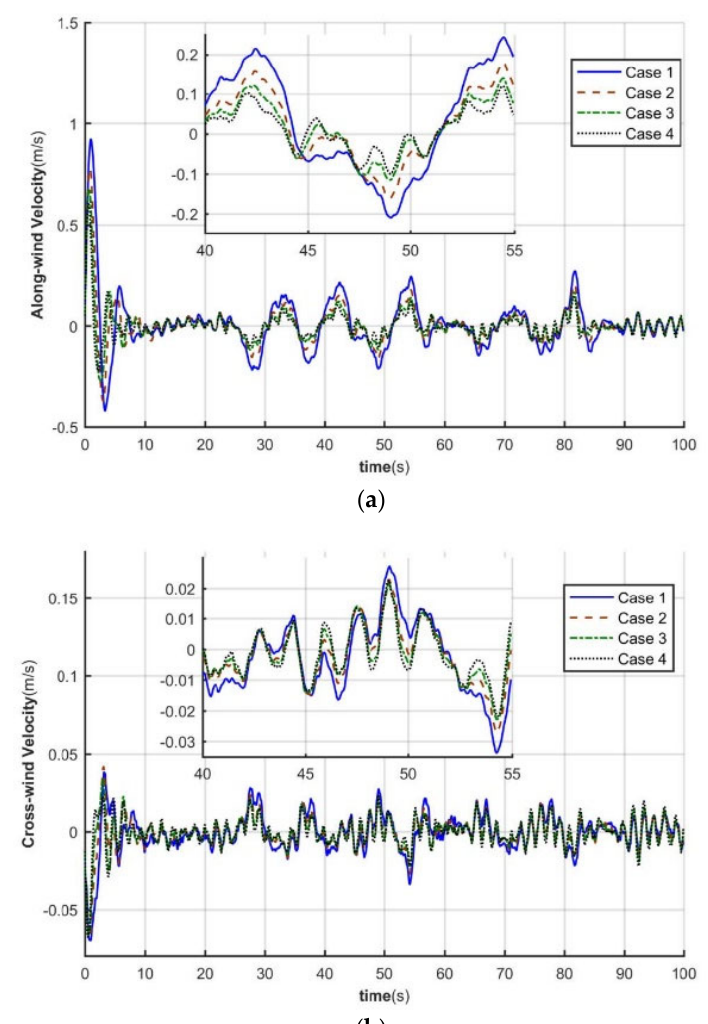
Figure 12. Time course of tower top speed ( a ) Downwind ( b ) Sidewind direction.